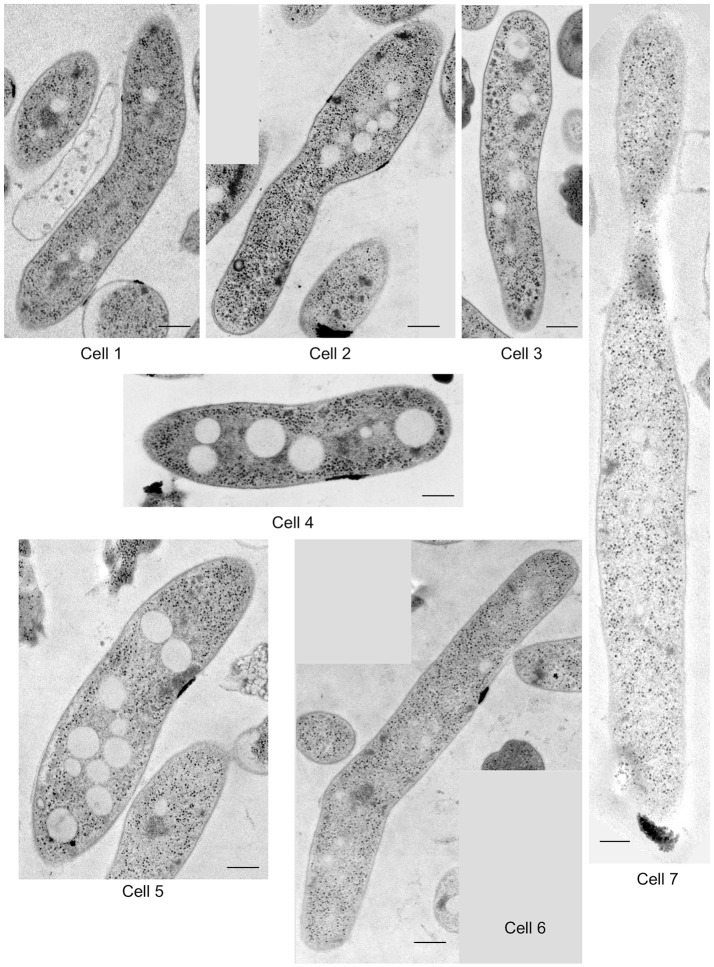
One of the representative images of serial ultrathin sections in seven M. smegmatis cells examined in structome analysis. Scale bar = 250 nm.